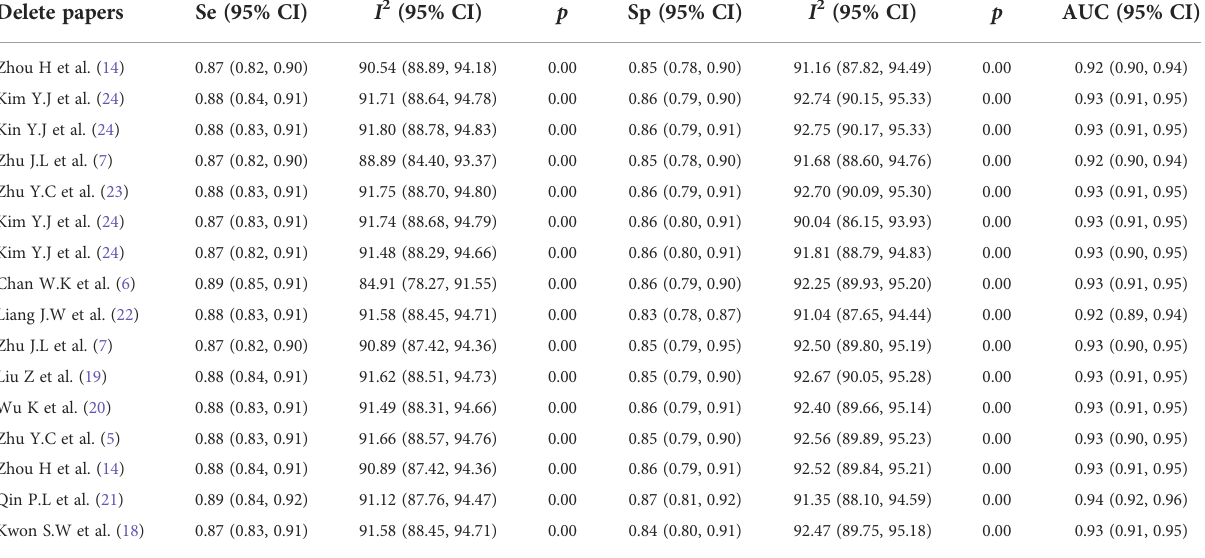
TABLE 3 The sensitivity analysis using the method of eliminating papers one by one. Delete